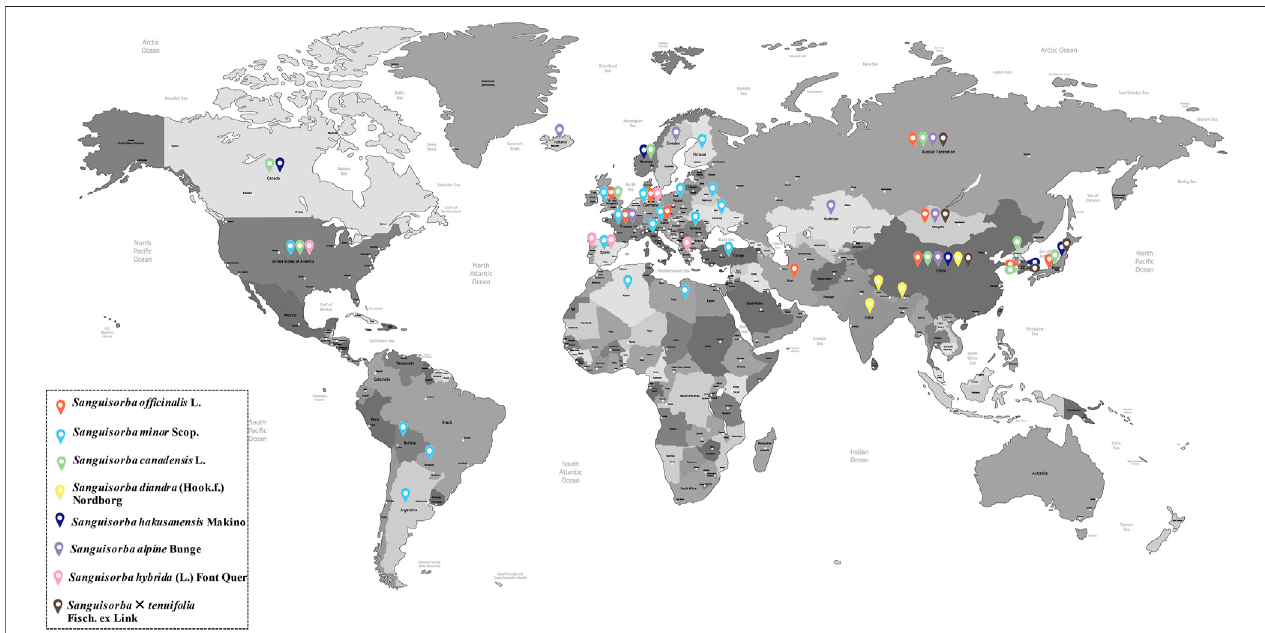
FIGURE 2 | The speci fi c distribution of genus Sanguisorba.